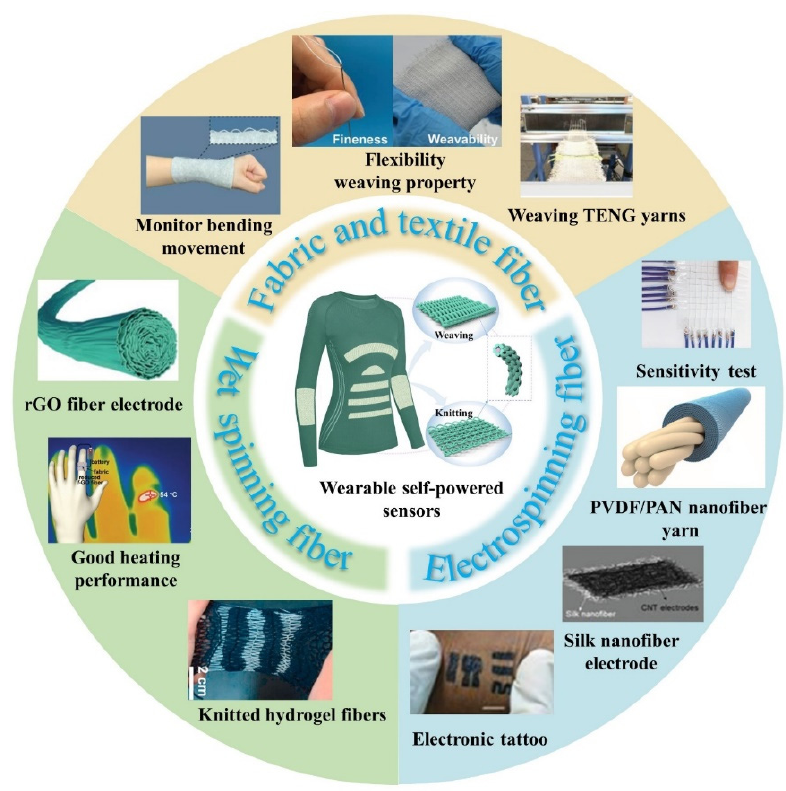
Figure 1. Schematic of recently reported fabric/fiber ‐ based TENG.